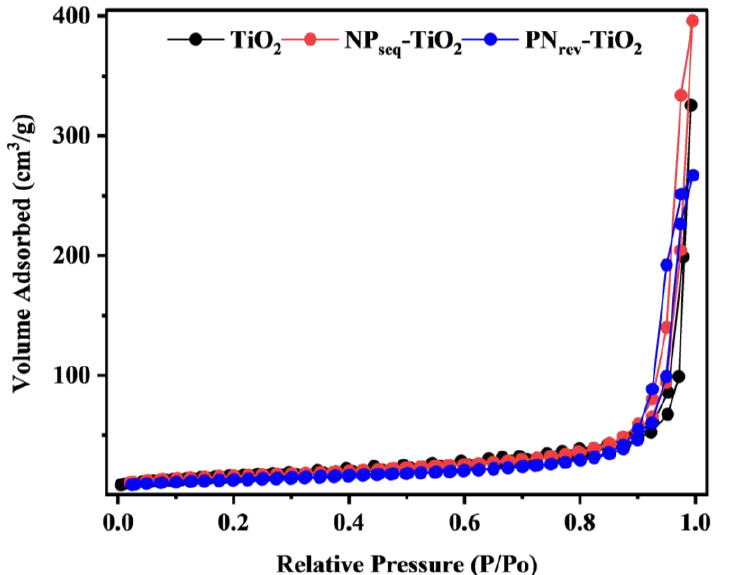
Figure 7. The nitrogen adsorption–desorption isotherm for TiO 2 , NP seq -TiO 2 , and PN rev -TiO 2 photo- catalysts.